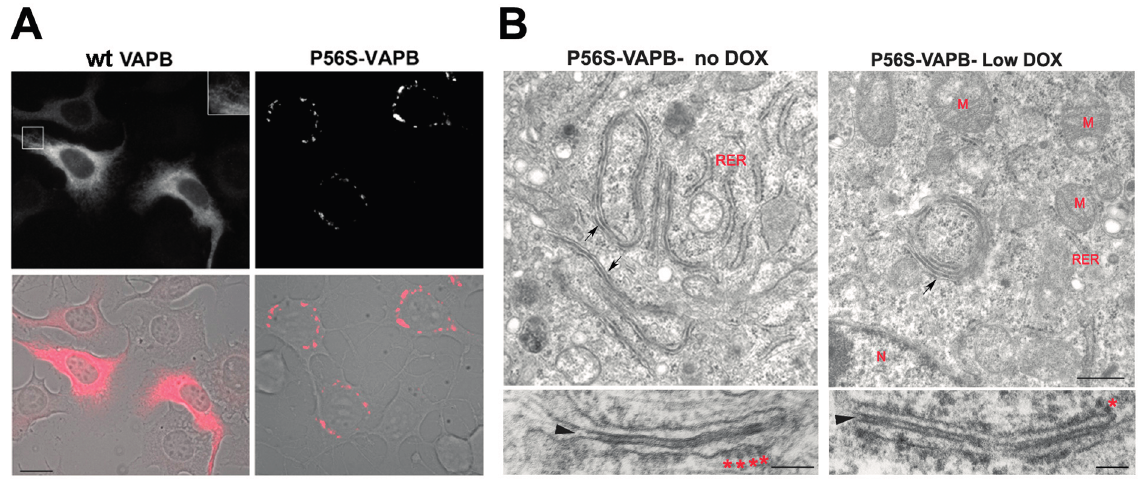
Figure 2. Mutant VAPB inclusions in a model motor neuronal cell line (NSC34 cells) ( A ) and in HeLa cells ( B ). ( A ) NSC34 cells stably transfected with wild-type (left) or P56S-VAPB (right) under a Tet-repressible promoter were grown in the absence of the antibiotic to induce expression of the transgene. Shown are fluorescence images (top) and fluorescence superimposed on the phase contrast images of the same two fields (bottom). The inset of the upper left panel shows a two-fold enlargement of the boxed area and illustrates the web-like distribution of wt VAPB, typical of an ER protein, as opposed to the clusters of mutant protein that congregate around the nucleus. Modified from [160]. Scale bar, 15 µm. ( B ) HeLa cell lines, expressing P56S-VAPB under a Tet-repressible promoter, were grown in the absence of the antibiotic (left) or at low concentration (right, 0.1 ng/mL) and then analyzed by transmission EM. Arrows in the upper panels indicate the paired cisternae with interposed dense cytosolic layer; such structures can be visualized both in moderately (left) and low (right) expressing cells. The lower panels show the inclusions at higher magnification. The arrowheads and asterisks indicate the dense cytosolic layer and attached ribosomes, respectively. RER, rough endoplasmic reticulum, M, mitochondria, N, nucleus. Scale bars: upper panels, 500 nm; lower panels 100 nm. Modified from